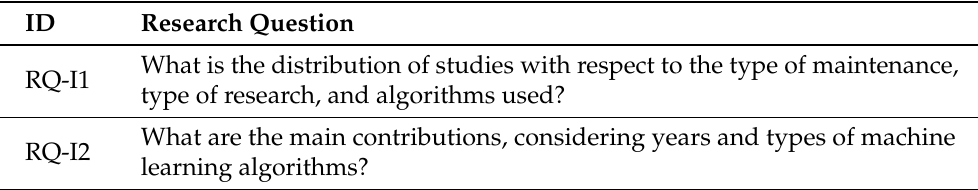
Table 5. Research questions on the intersection of